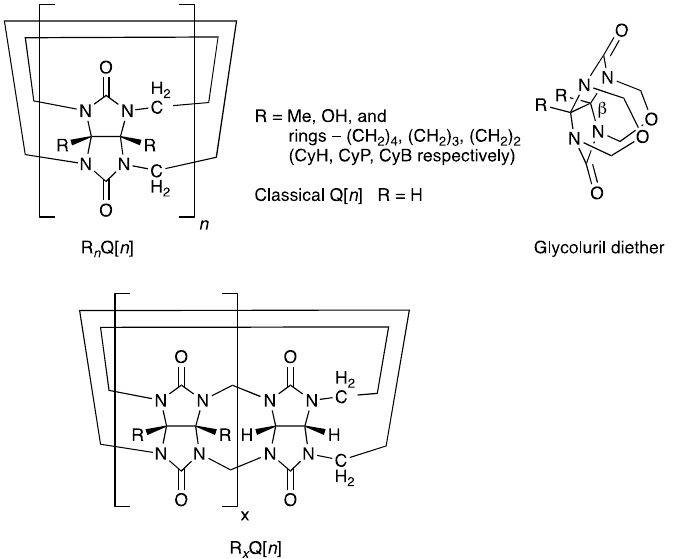
Figure 1. Classical Q[ n ] is represented above, where all R = H (top LHS). Fully substituted derivatives R n Q[ n ] are shown for the five known examples (top LHS). Partially substituted derivatives are R x Q[ n ] (bottom). Glycoluril diether identifying the β ° angle is discussed in the text (RHS).